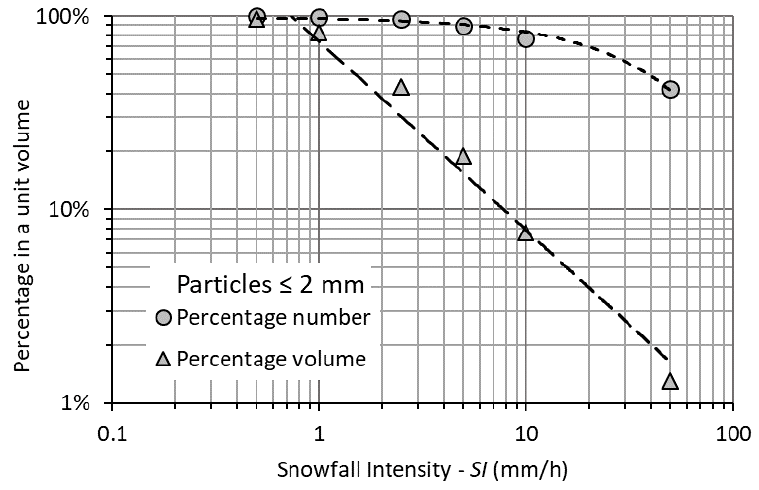
Figure 11. Percentage number and volume of particles having a diameter less than 2 mm within a unit volume of the atmosphere, based on the assumed particle size distribution (PSD).